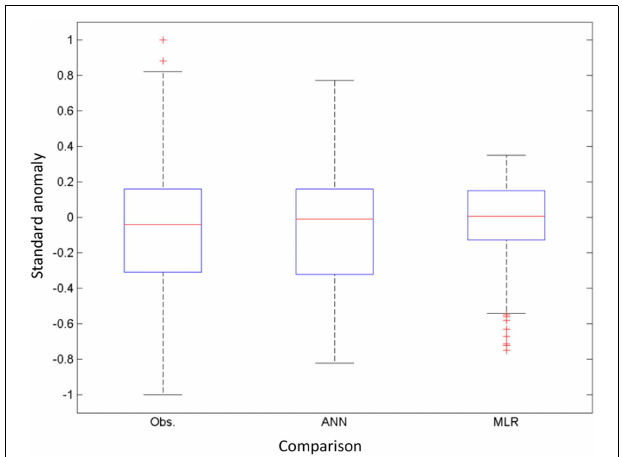
FIGURE 11 | Box-plots comparison between observed and simulated daily precipitation by the ANN and MLR models during FMA season of the 1963–2003 period over the north of the NEB.